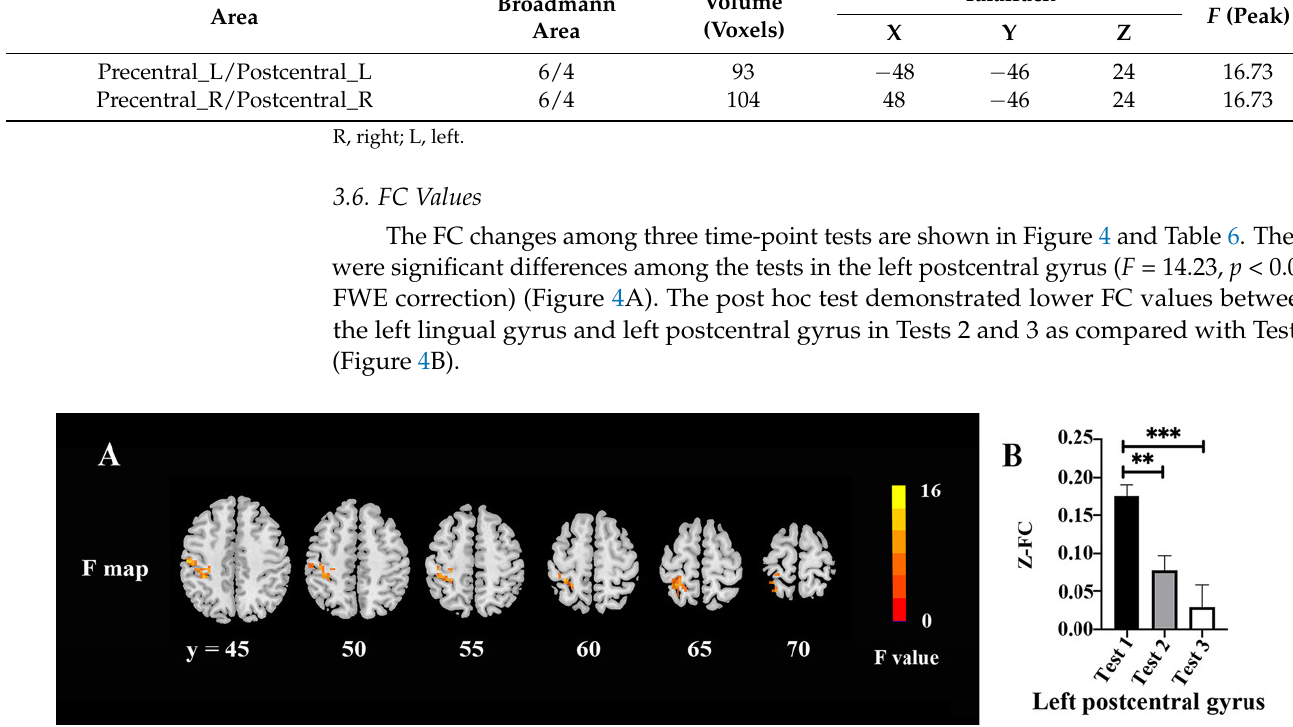
Figure 3. VMHC changes among the three time points. ( A ) Difference of VMHC maps among the three time points. ( B ) Extracted clusters of significant VMHC alteration in three time points. ** p < 0.01 and *** p < 0.001. Table 5. Regional information of changed VMHC in repeat ANOVA.